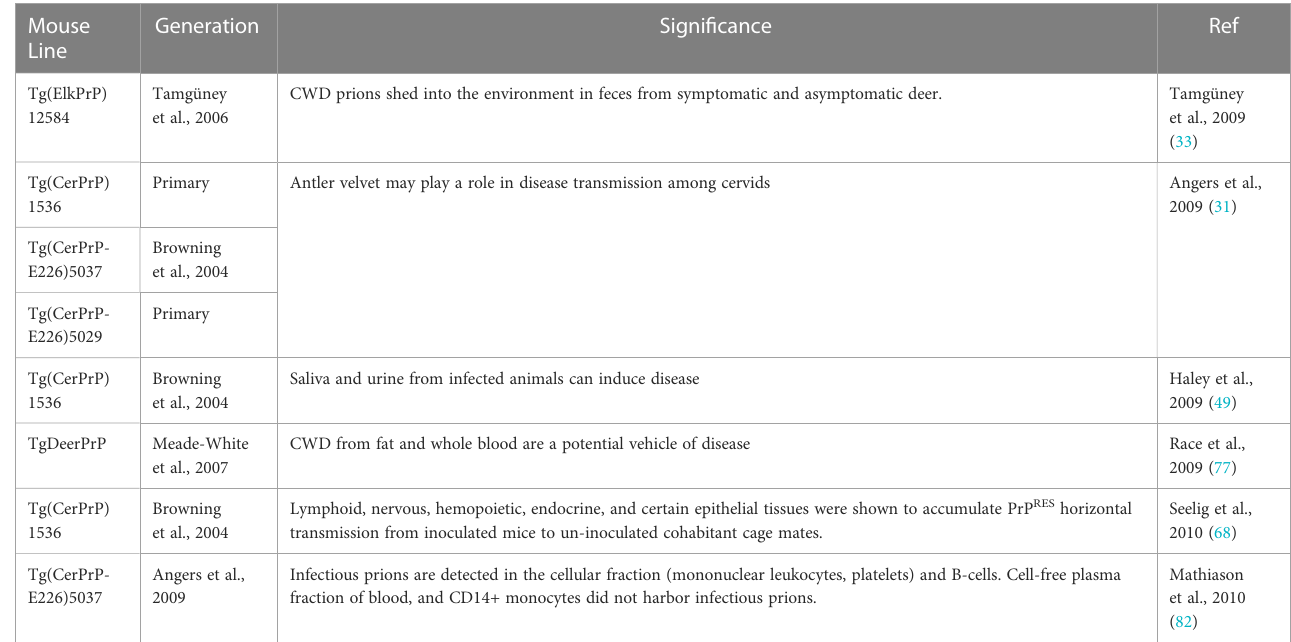
TABLE 2 Investigations of infectious